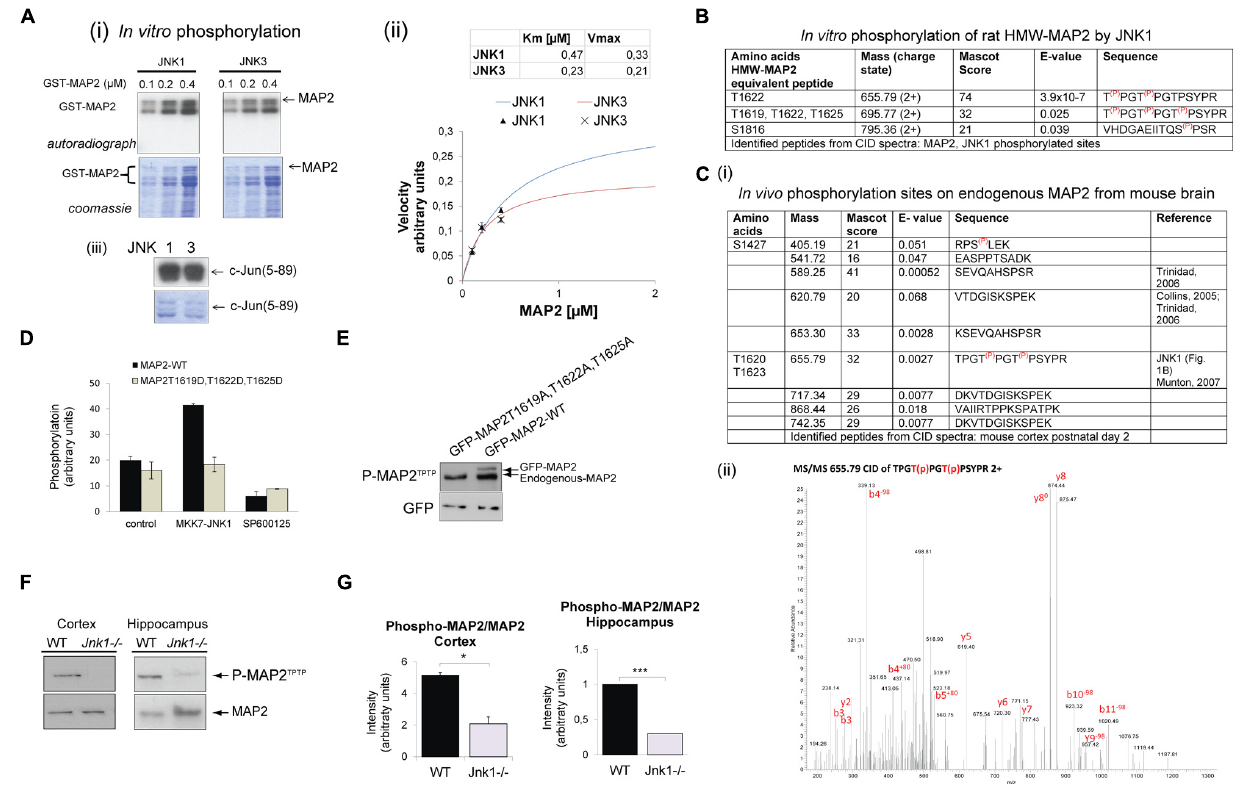
FIGURE 1 | JNK1 phosphorylates the PRD of MAP2 on T1619,T1622 and T1625 in vivo in the cortex and hippocampus. (A) (i) Increasing concentrations of recombinant GST-MAP2 was phosphorylated in vitro by active recombinant JNK1 α 1 or JNK3 α 1. The relative phosphorylation by JNK1 and JNK3 can be visualized from the autoradiograph. (ii) Quantitative data obtained from phosphor-imaging is shown. JNK1 shows a higher V max compared to JNK3. Meaned data ± SEM from four repeats is shown. (iii) The catalytic activities of JNK1 and JNK3 were tested for c-Jun(5–89) phosphorylation demonstrating comparable catalytic activity. (B) GST-MAP2 phosphorylated in vitro by JNK1 was subjected to phospho-peptide purification using TiO 2 and MS/MS analysis. Identified peptides from collision induced dispersion spectra are shown in the table. T1622 and T1625 (HMW-MAP2 equivalent residues) were clearly phosphorylated. In addition a triply phosphorylated peptide phosphorylated on T1619, T1622, T1625 was identified. (C) (i) The in vivo phosphorylation sites of MAP2 determined from postnatal day 2 mouse cortex ex vivo are shown. Sites S1427, T1622, and T1625 contained covalently bound phosphate. ( ii ) A MS/MS spectra of the dual phosphorylated HMW-MAP2 phosphopeptide isolated from brain is shown. (D) To determine whether active JNK phosphorylated MAP2 in living cells, COS-7 cells were